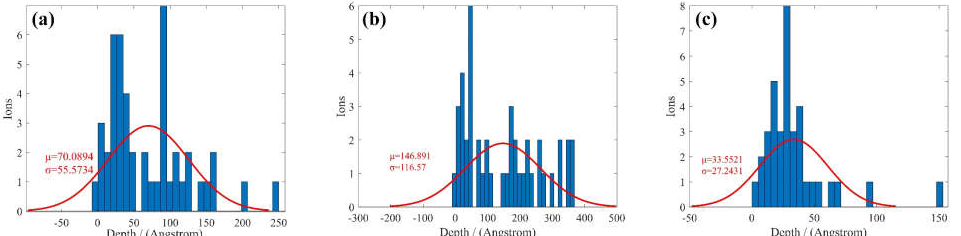
Figure 5. Ar atoms distribution and corresponding Gaussian distribution fitting of, ( a ) Al(001), ( b ) Al(110), ( c ) Al(111).